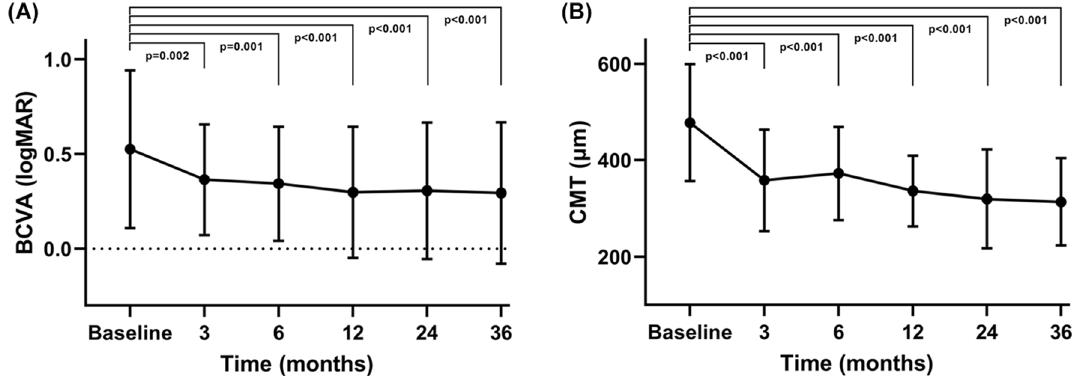
Figure 1. Changes in the mean and standard deviation of the logarithm of the minimal angle of resolution (logMAR) best-corrected visual acuity (BCVA) and central macular thickness (CMT) at 3, 6, 12, 24, and 36 months after vitrectomy combined with intraoperative dexamethasone implantation for non-tractional refractory diabetic macular edema. Statistical significance was determined using a generalized estimating equation model accounting for the correlation structure of paired eyes. ( A ) The logMAR BCVA significantly improved postoperatively compared to the baseline during follow-up. ( B ) The CMT was significantly thinner postoperatively than preoperatively. The average CMT at 6 months was slightly thicker than that at 3 months, but the difference was not statistically significant ( p = 0.258).